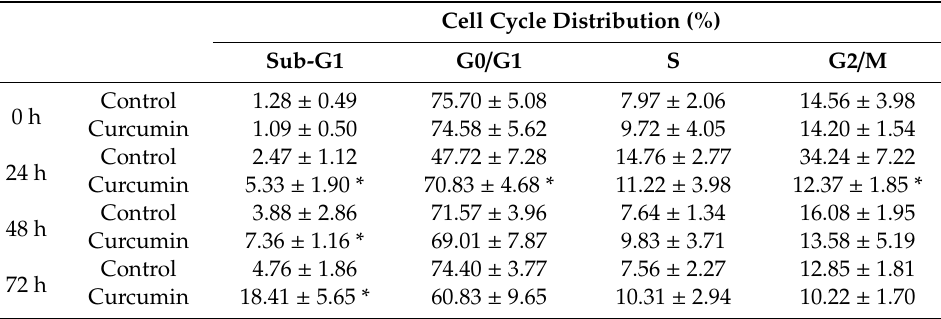
Figure 1. E ff ect of curcumin on the viability of 3T3-L1 preadipocytes. ( A ) 3T3-L1 preadipocytes were pretreated with 0–50 µ M curcumin for 1 h, then were incubated with di ff erentiation medium in the continued presence of the same concentration of curcumin for 24 h (white bars), 48 h (gray bars), or 72 h (black bars) and cell viability was determined using the MTT assay. The results are shown as the mean ± SD for four independent experiments. * P < 0.05 compared to the vehicle control. ( B ) 3T3-L1 preadipocytes were pretreated with 0 or 30 µ M curcumin for 0–72 h, then the cell cycle distribution was analyzed by flow cytometry. The results shown are representative of those in four separate experiments. Table 1. E ff ect of 30 µ M curcumin on the cell cycle of 3T3-L1